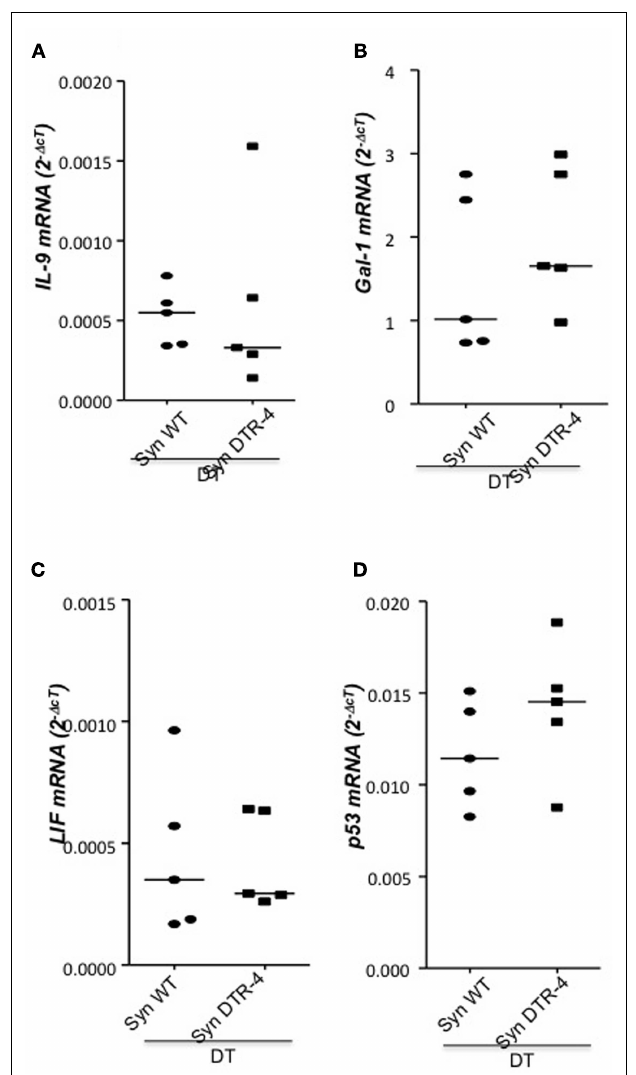
FIGURE 7 |Treg depletion does not provoke changes in IL-9, Gal-1, LIF, or p53 . In samples from Foxp3.LuciDTR-4 or wild type animals treated with DT by daily application starting on day 2 and further mated allogeneically, inflammation markers were measured ( n = 4–6/group) in uterine tissue by qPCR. Levels of IL-9 (A) , Gal-1 (B) , LIF (C) , and p53 (D) mRNA were comparable in mice depleted ofTregs and DT-treated controls. Data are expressed as single dot plots with medians and were analyzed by Mann–Whitney- U test. No statistically significant differences were observed between both groups in any of the molecules.